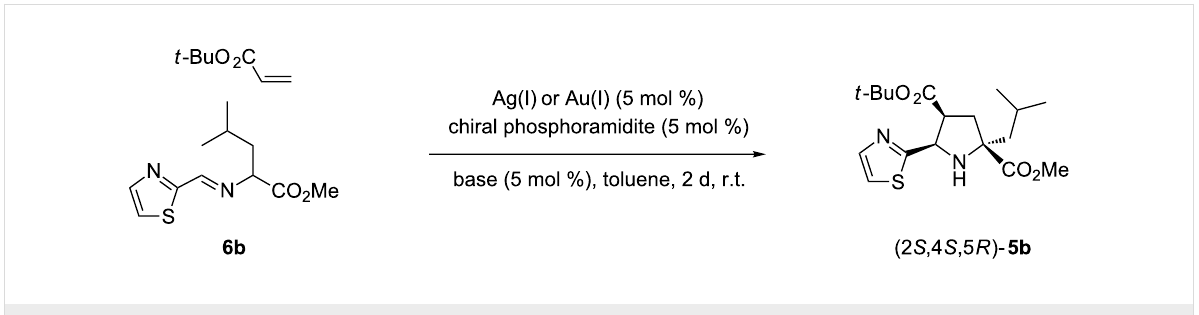
Scheme 2: Optimization of the reaction conditions for the synthesis of the key intermediate 5b .